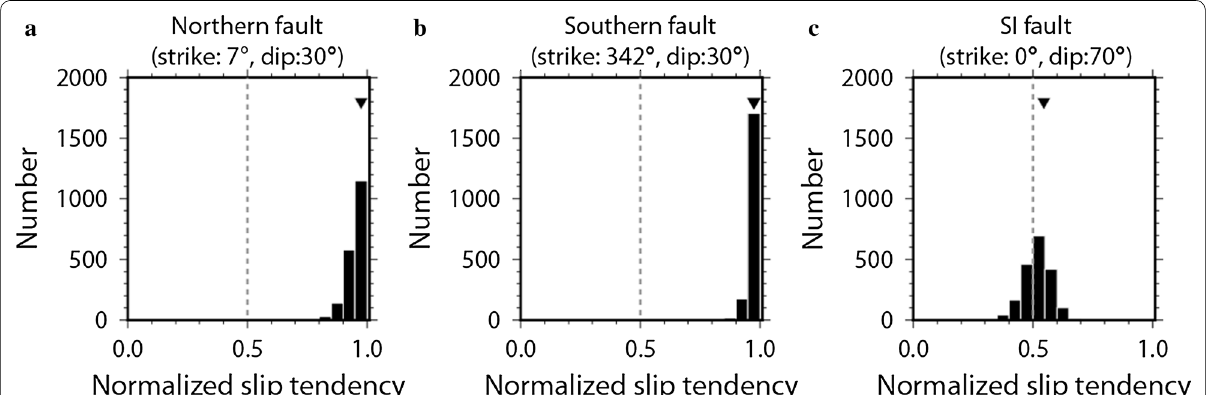
Fig. 3 Frequency of the normalized slip tendency computed from the 95% confidence region of the stress tensor in Fig. 2b. The inverted triangles show the normalized slip tendency of the best stress tensor. The gray dotted line indicates the boundary as to whether or not the fault is easy to move under the assumed stress tensor (Collettini and Trippetta 2007). For the case of a northern, b southern, and c SI